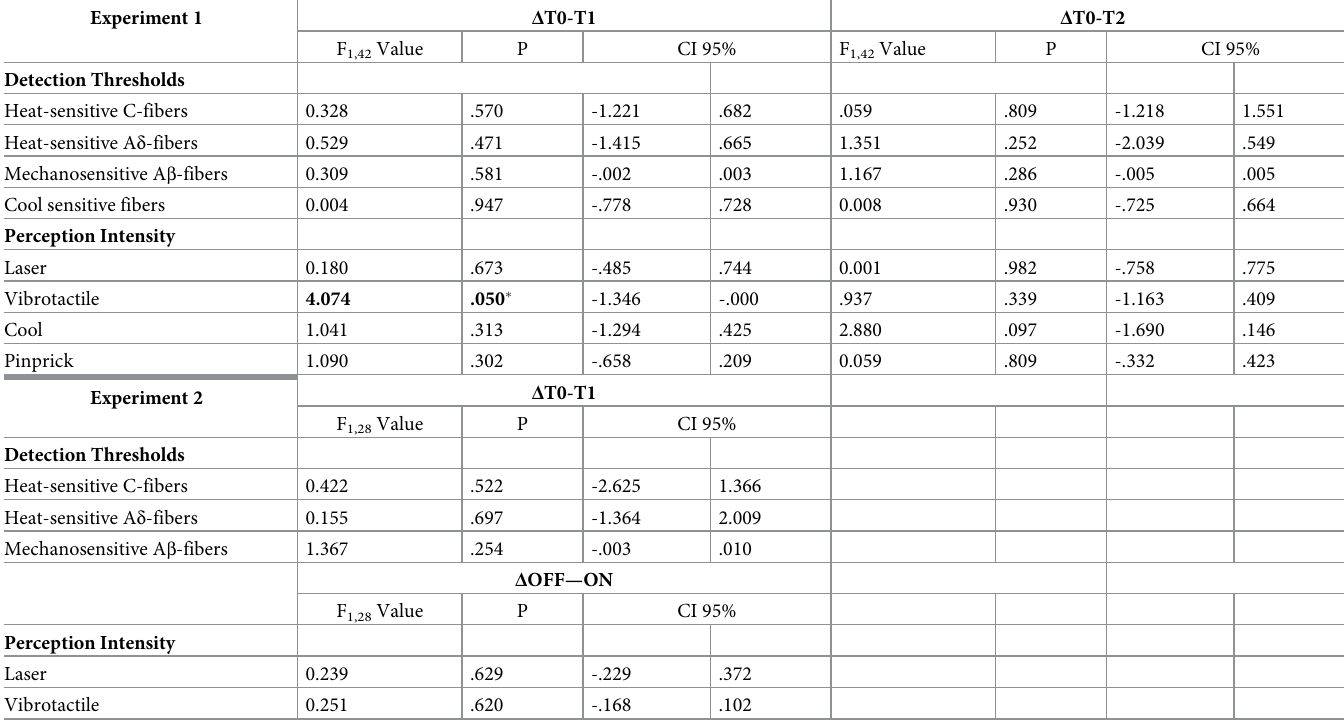
Table 3. Linear mixed models with within-subject factors ‘condition’: Δ Detection thresholds and Δ Perception intensity (Experiment 1–2). Experiment